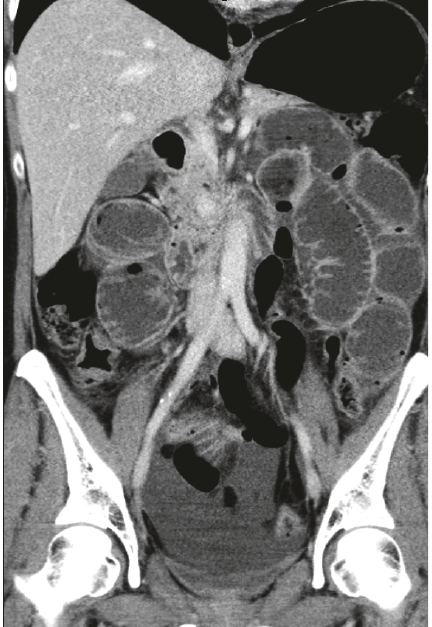
Figure 1: CT of the abdomen: picture of a mechanical small bowel ileus. The colon is not involved. Thus, the caliber jump is most likely in the preterminal ileum, but this cannot be demonstrated on the CT